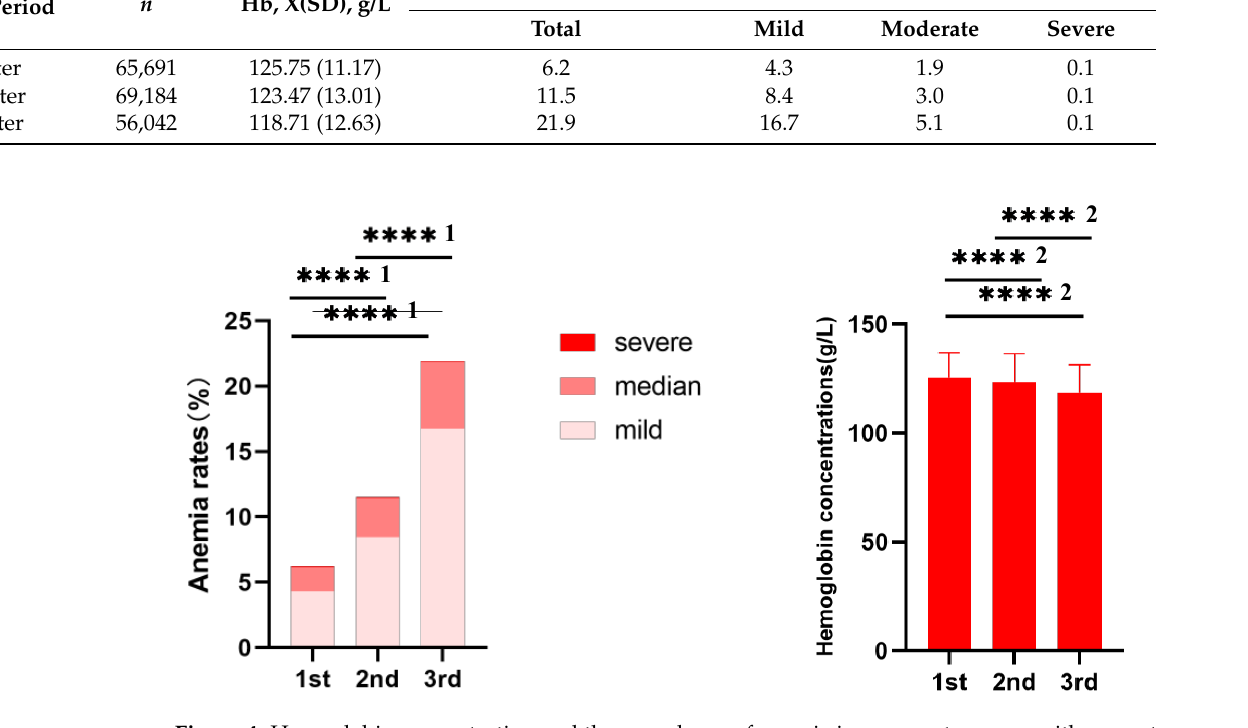
Figure 4. Hemoglobin concentration and the prevalence of anemia in pregnant women with respect to trimester. **** 1 : p < 0.001, from One-way ANOVA. **** 2 : p < 0.001, from Pearson’s chi-square test. Table 4. The hemoglobin concentration in subgroups according to trimester.